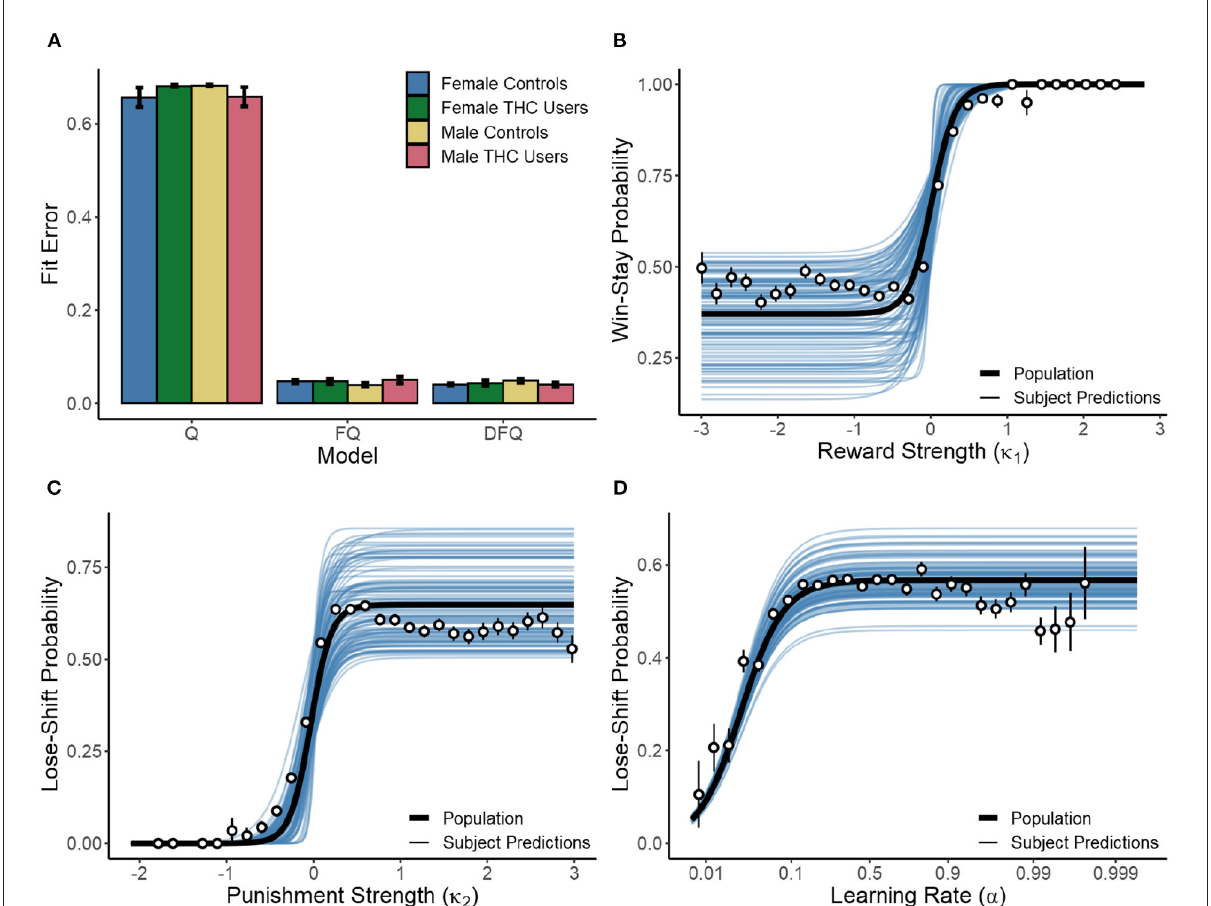
FIGURE5 (A) Performance of the Q-learning (Q), Q-learning with forgetting (FQ), and Q-learning with differential forgetting (DFQ) models. (B) Relationship between κ 1 and win-stay behavior with curves fit to individual subjects (blue lines), the population average (black line), and averages of binned raw data (points). (C,D) Relationship between κ 2 & α and lose-shift behavior. α was normalized via the logit transform prior to model fitting.